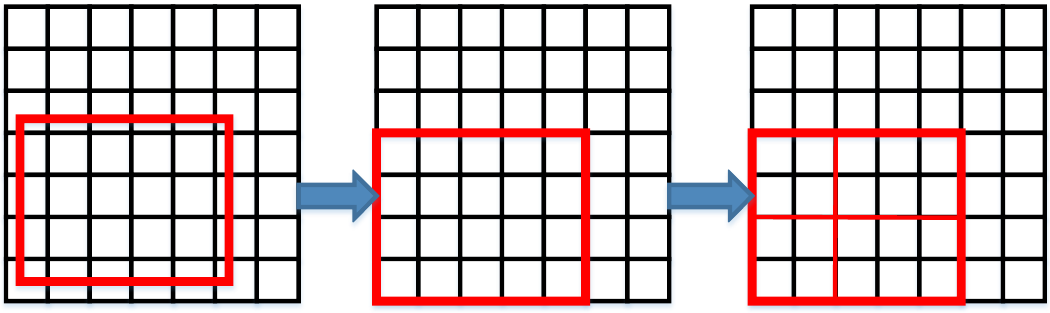
Figure 3. The integer processing of Region of Interest (RoI) Pooling.